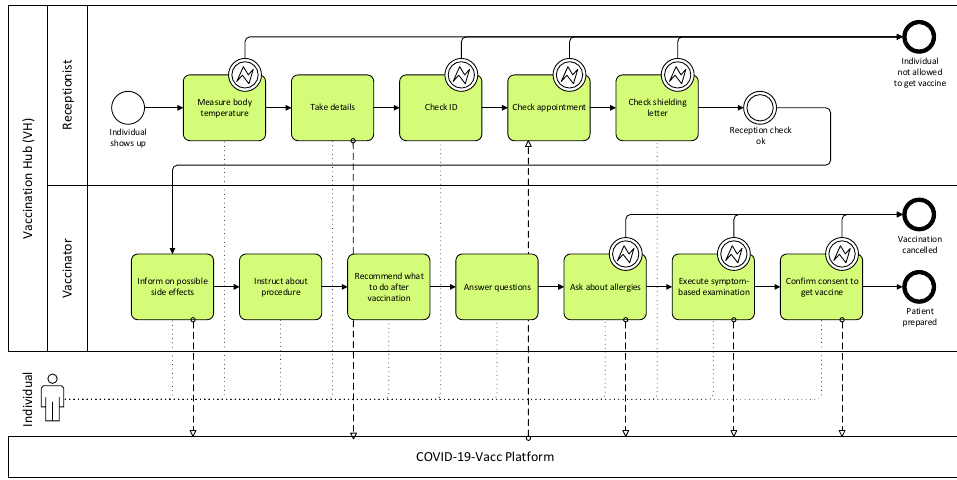
Figure 9. Exemplary patient preparation process from a vaccination hub (VH)